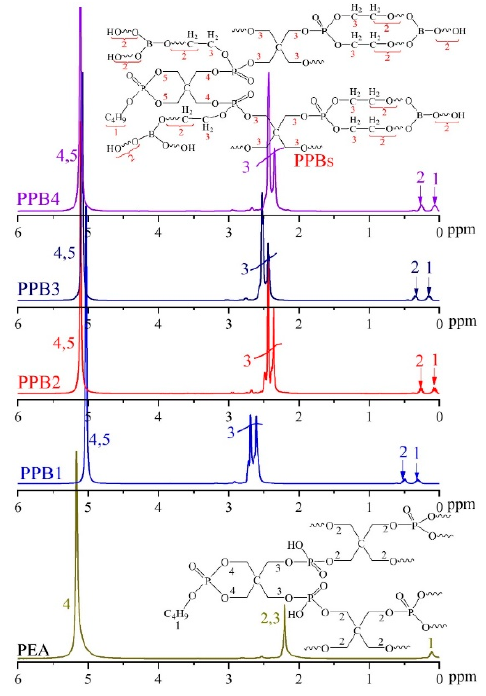
Figure 3. 1 H NMR spectra of the PPBs flame retardants.